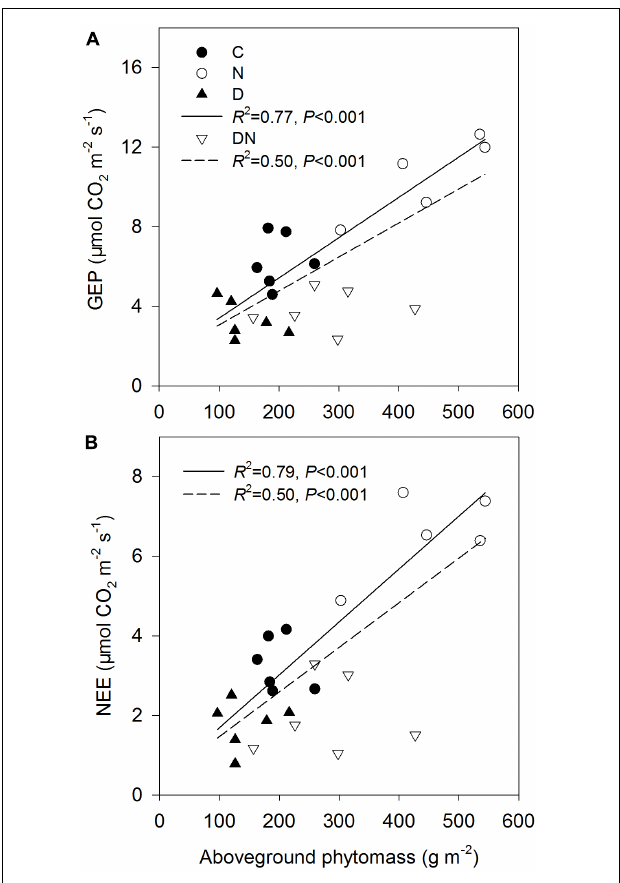
FIGURE 5 | Relationships between gross ecosystem productivity (GEP) (A) and ecosystem CO 2 exchange (NEE) (B) and aboveground phytomass across all the treatments except DN treatment (solid line) and all the treatments (dash line) at the end of the drought period (DOY 196 in